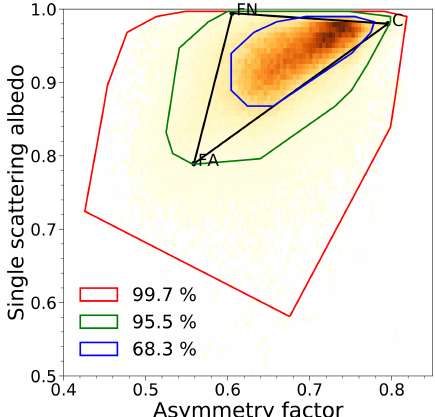
Figure 4. Solution space (black triangle) for the wavelength 0.6µm defined by the non-absorbing fine-mode (FN), the absorbing fine- mode (FA) and the coarse-mode (C) vertices. The red, green and blue lines show the 99.7%, 95.5% and 68.3% probability regions respectively, derived from AERONET inversion product for all the observations available over all the AERONET